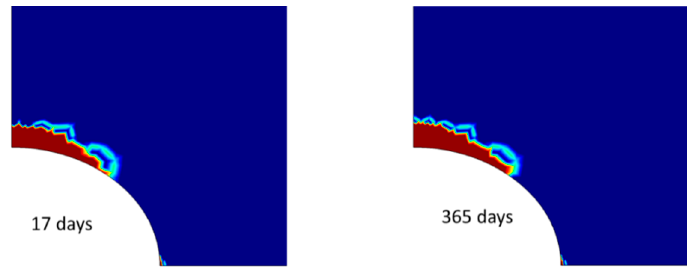
Figure 14. Simulated excavation damage zone around the TSX tunnel.